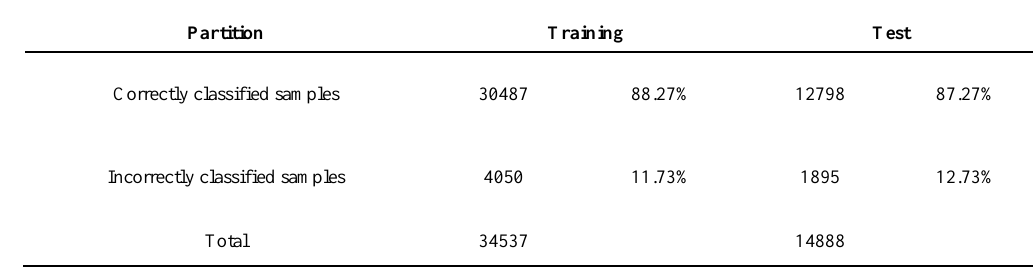
Table 14. Accuracy of decision tree of Pin Pad transactions with respect to month and year.